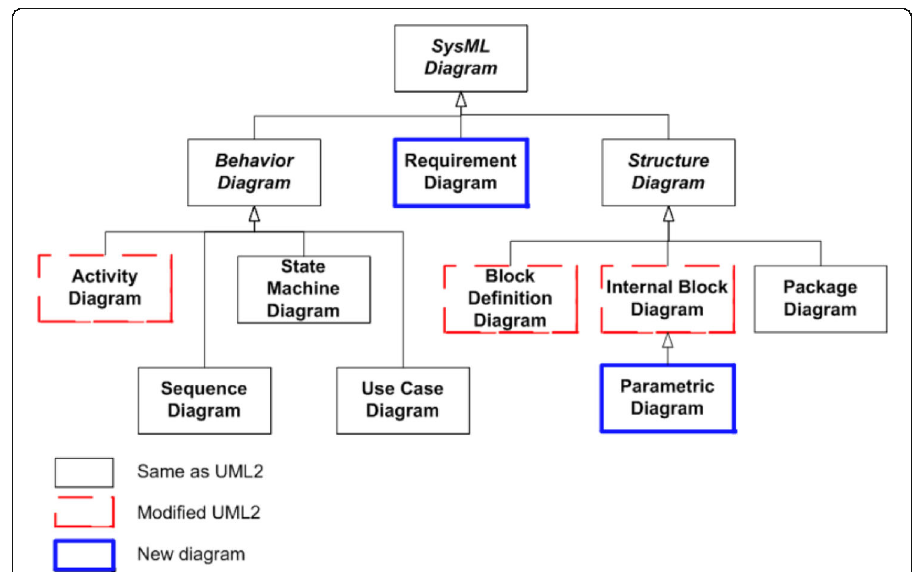
Fig. 6 SysML diagram taxonomy (SysML.org